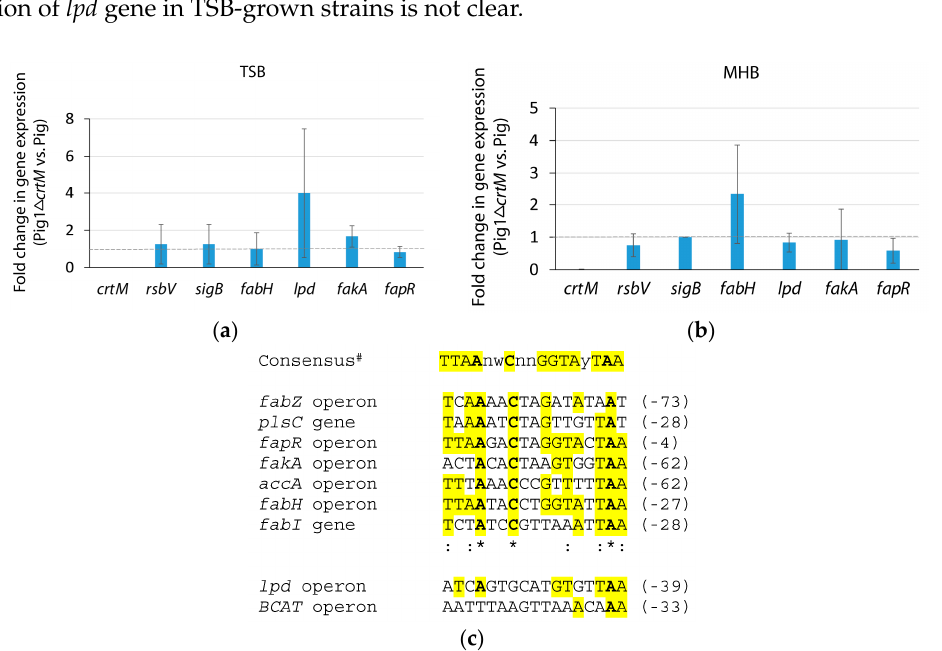
parentheses after each operator sequence in ( c ) indicates the last nucleotide in the given sequence. # [30].